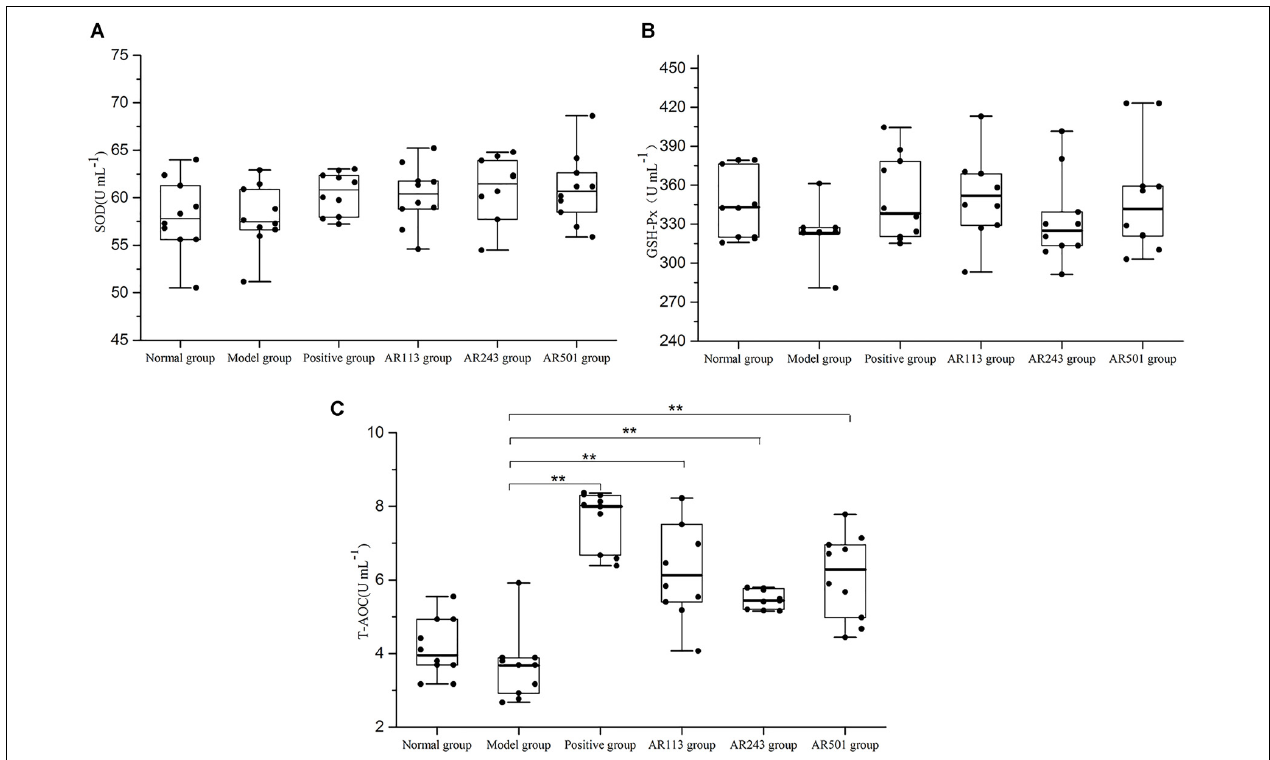
FIGURE 3 | Effect of LAB on oxidized oil induced changes in the activity of SOD (A) , GSH-Px (B) and T-AOC (C) in serum of mice. Where U/L means the biological value of SOD, GSH-Px or T-AOC in per milliliter serum. Values are expressed as mean ± SD ( n = 10), ∗ p < 0.05 vs. model group, ∗∗ p < 0.01 vs. model